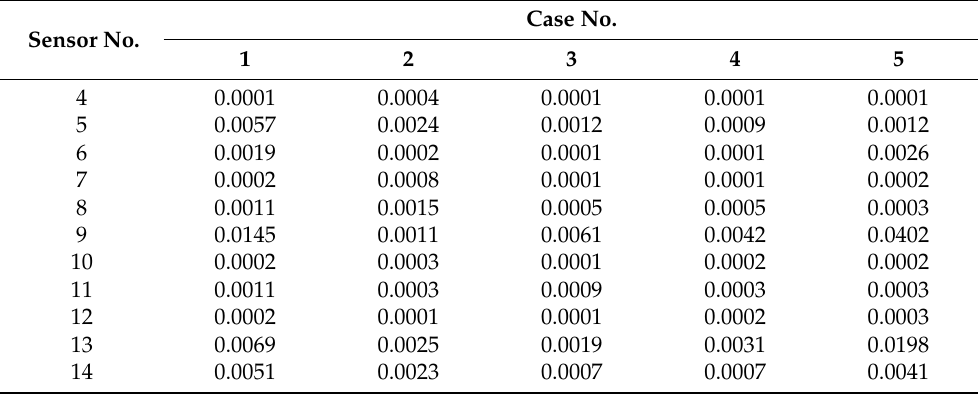
Table 3. ASCE problem: Leybourne–McCabe (LMC) test statistics for all sensors and Cases 1–5 of Table 2. Sensor